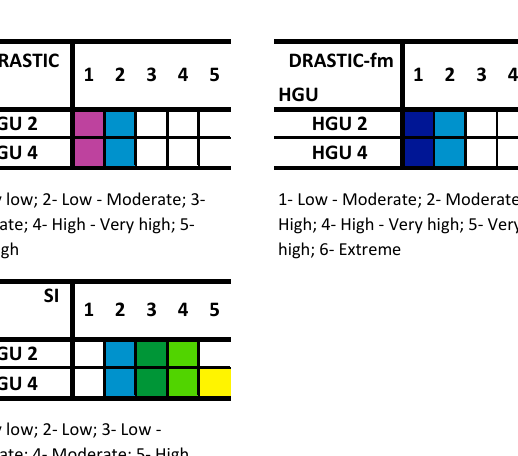
indexes for contamination in the Penafiel urban area (NW Portugal).